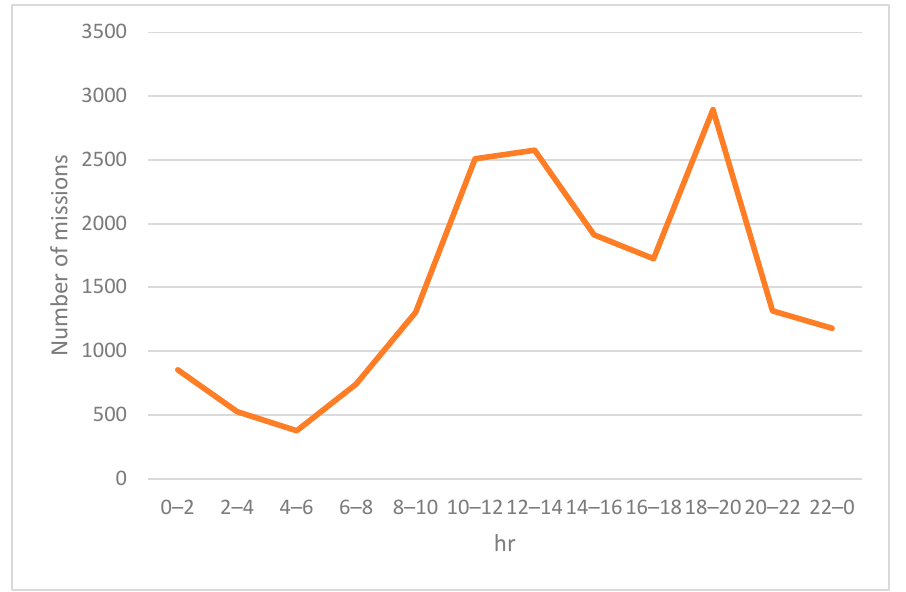
Figure 5. Volume of emergency missions performed by the UAVs within a day.